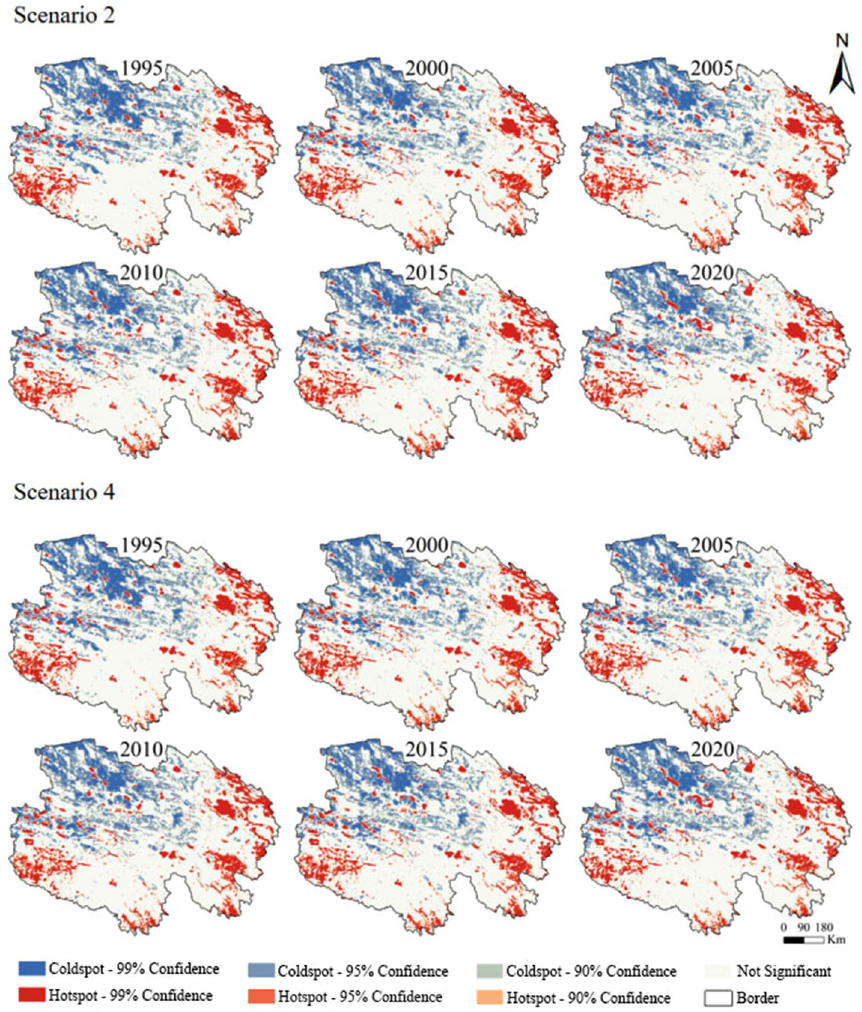
Figure 7. Spatial distribution of the coldspots and hotspots of ESSVs for scenario 2 and scenario 4 (made in ArcGIS 10.4.1, https:// www. esri. com/ zh- cn/ arcgis/ produ cts/ arcgis- deskt op/ resou